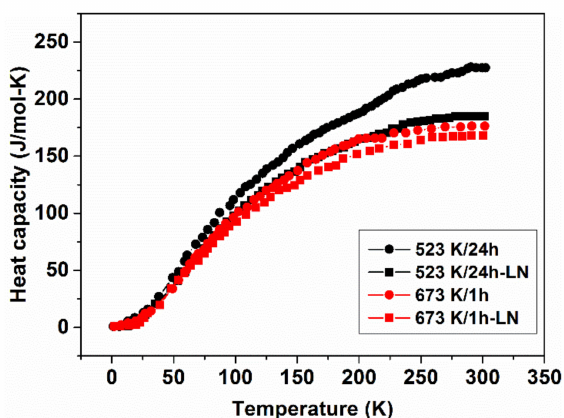
Figure24. HeatcapacityofFe 40 Ni 40 Si 6 B 14 glassysampleswithandwithoutLNtreatments. Thesamples were previously subjected to isothermal heat treatments at 523 or 673 K, respectively. Adopted from [98], with permission from IEEE,